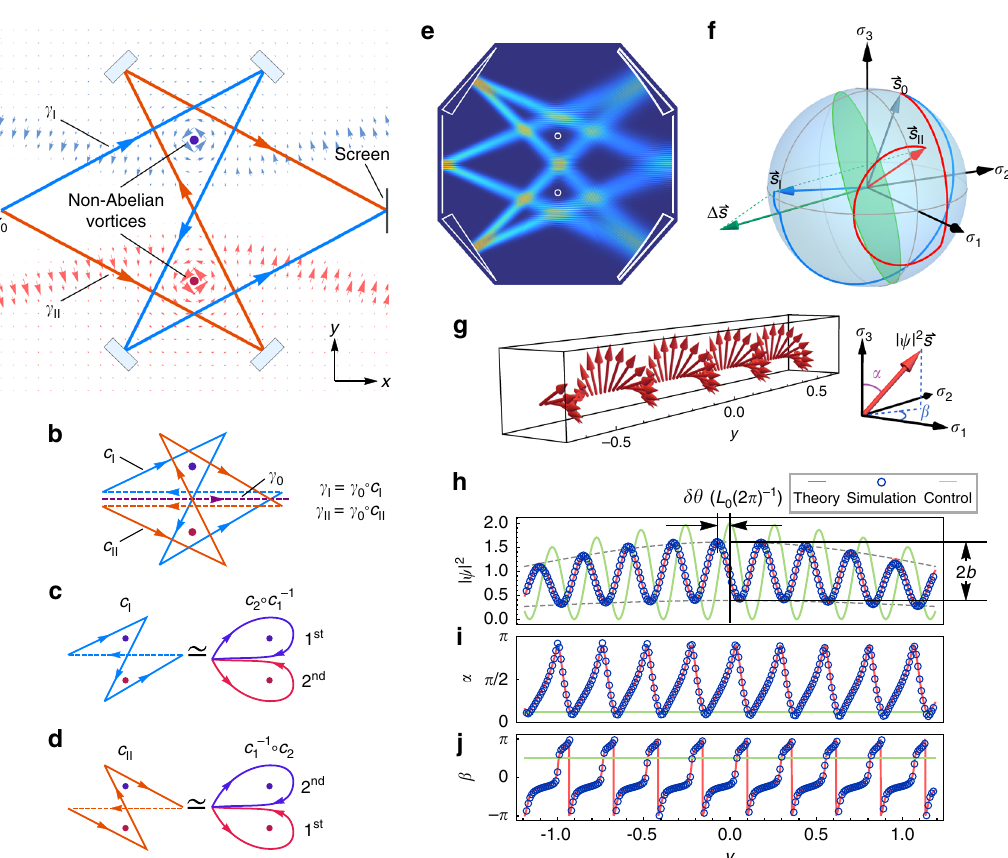
, γ interfering on the screen, where the Fig. 3 Genuine non-Abelian AB effect for light. a Sketch of the non-Abelian AB system with two optical paths γ I II background light blue (red) arrows denote the ^ σ 1 ( ^ σ 2 ) component A 1 ðA 2 Þ of the non-Abelian vector potential. b γ ( γ ) can be divided into a closed loop c I I II ( c ) and a common path γ 0 . c , d c I and c II can, respectively, deform continuously into a closed path that winds around the two vortices successively but in II opposite sequences. e Snapshot of the simulated fi eld intensity for the proposed non-Abelian optical interferometer with incident spinor ð 1 ; i 1 = 5 Þ > for both beams and the vortex fl uxes Φ 1 ¼ (cid:2) 2 π = 3, Φ 2 ¼ (cid:2) π = 3. f Spin evolution on the Bloch sphere along two beams γ , γ , which share the same initial spin ~ s 0 but I II achieve different fi nal spins ~ s and ~ s . g Spin density interference corresponding to e , where each arrow denotes the local pseudo-spin density j ψ j 2 ~ s at a I II ~ s point on the screen. All of the local spins ~ s ð y Þ are perpendicular to Δ ~ s ¼ ~ s , and thus fall on the green circle in f . The corresponding intensity I (cid:2) II interference j ψ j 2 ð y Þ and the two Euler angles α , β of the local spins ~ s ð y Þ on the screen are shown in h – j , where blue circles and red curves indicate simulated and theoretical results, respectively, and δθ , b are the phase shift and relative amplitude relative to the case of ^ A ¼ 0 ( L 0 is the period of Δ θ ð y Þ mod 2 π ). The green lines correspond to the “ control experiment